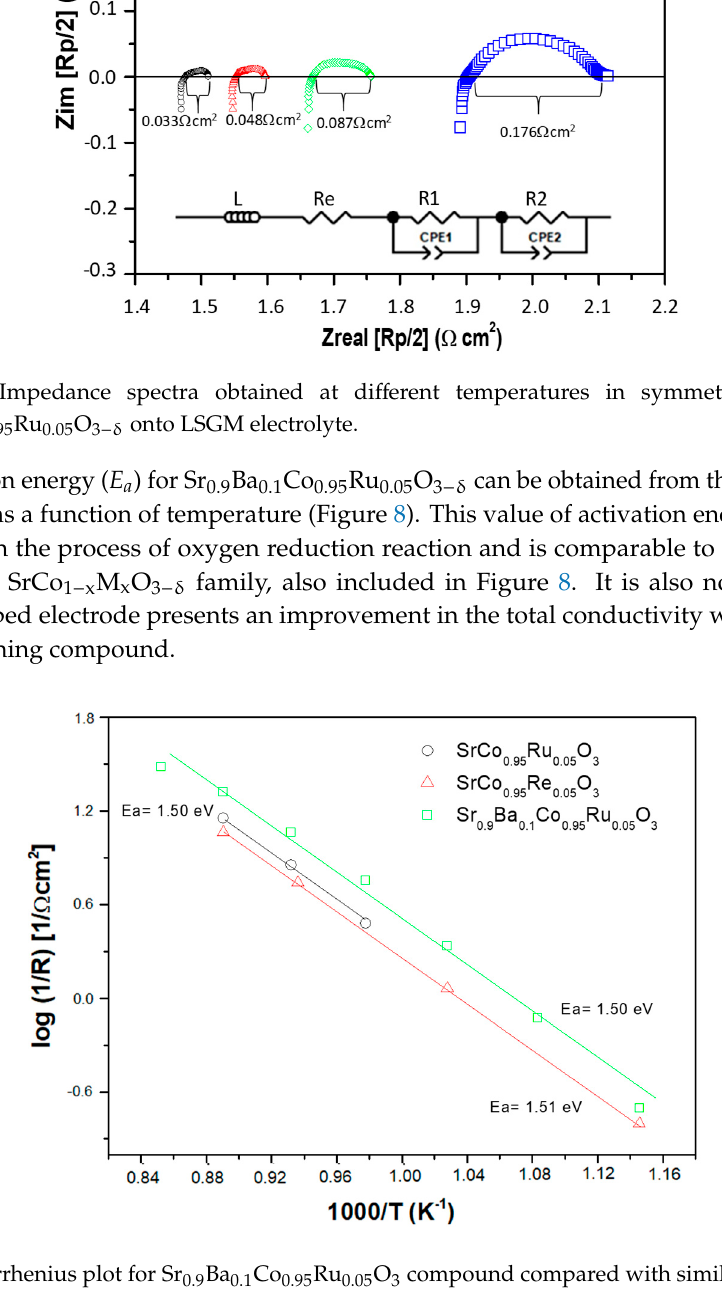
Figure 8. Arrhenius plot for Sr 0.9 Ba 0.1 Co 0.95 Ru 0.05 O 3 compound compared with similar cathodes.